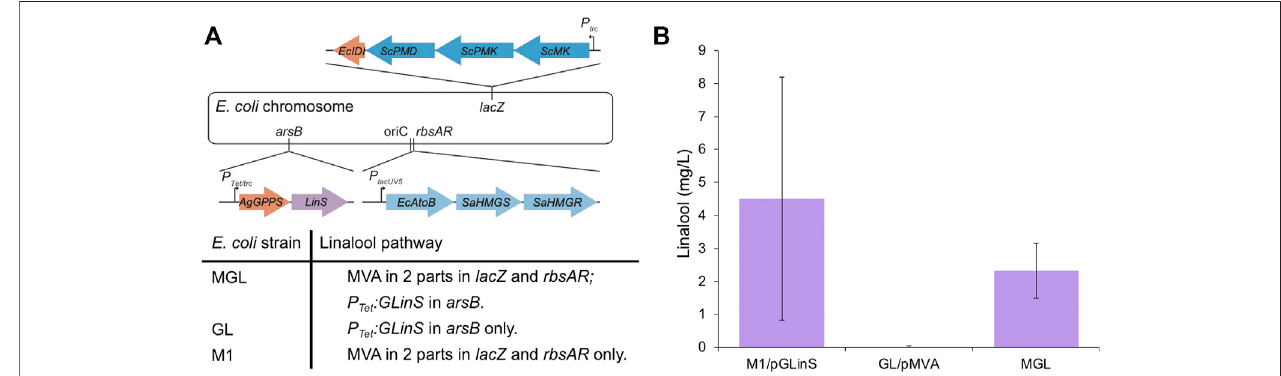
FIGURE 4 | Linalool production in E. coli containing genome integrated copies of the pathway. (A) Location of the three constitutive parts of the linalool-producing constructs integrated within different recombinant E. coli strains. The three loci where DNA cassettes were inserted were arsB , rbsAR and lacZ . For strains with a genomicMVA pathway integration,the genes EcAtoB , SaHMGS and SaHMGR wereinserted at the rbsAR loci, while the remaining genes( ScMK , ScPMK , ScPMD and EcIDI ) were inserted at the lacZ loci. (B) Linalool production of the partial and fully integrated pathway strains of E. coli DH5 α and the linalool tolerant evolved strain. Cultures (3 ml) were incubated in TB medium containing 0.4% glucose and antibiotic selection at 37 ° C until growth was visible, followed by induction with 50 µM IPTG (only M1) and 25 nM anhydrotetracycline. A further incubation at 30 ° C was performed for 68 – 72 h and linalool production was determined by GCMS analysis.